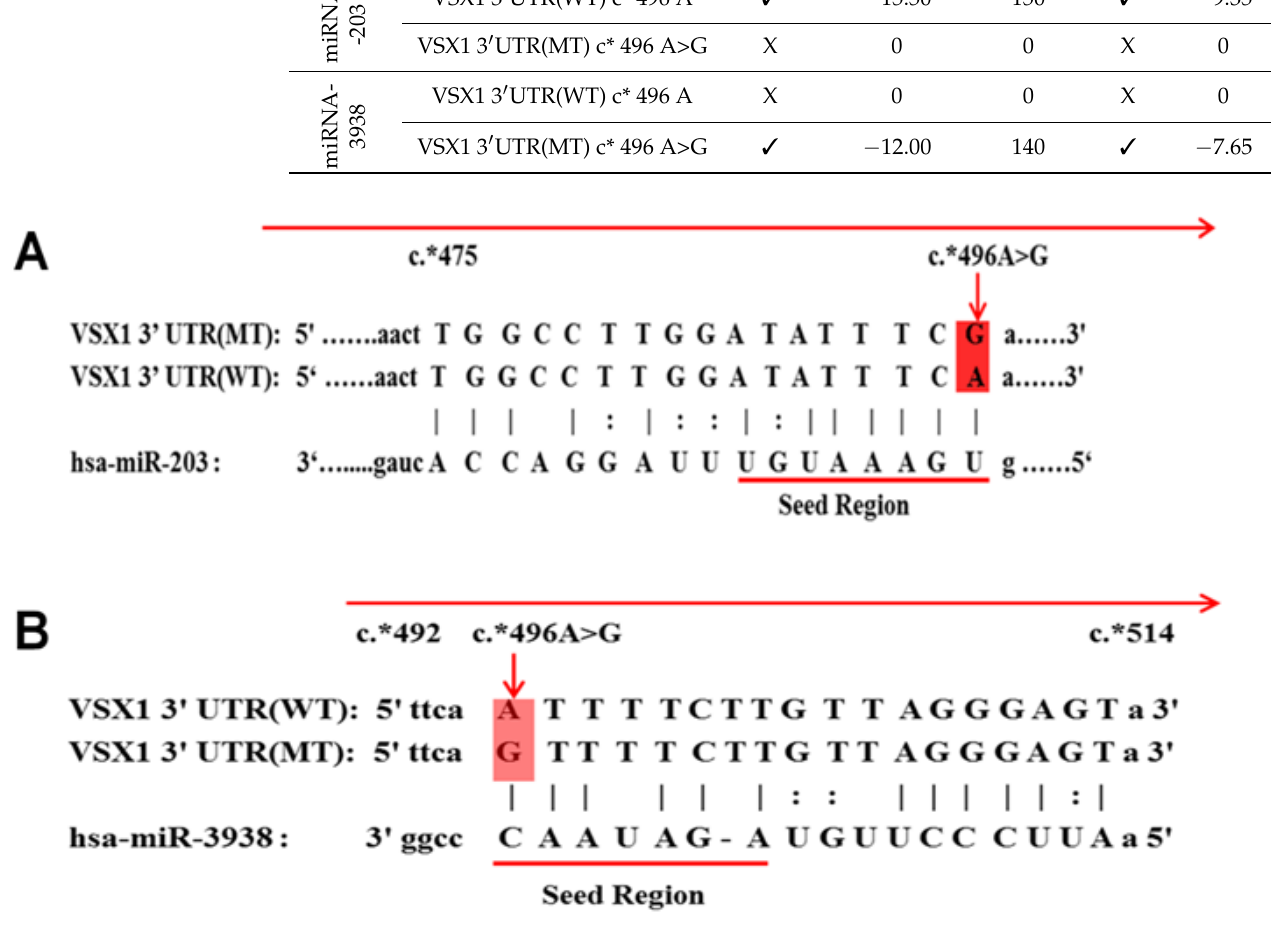
Figure 4. hsa-miRNA-203 binding site on VSX1 3′UTR(WT). ( A ) c*475-c*496 as predicted by PITA and miRANDA. ( B ) In the case of VSX1 3′UTR(MT) c*496 A>G, hsa-miRNA-203 there is no binding.